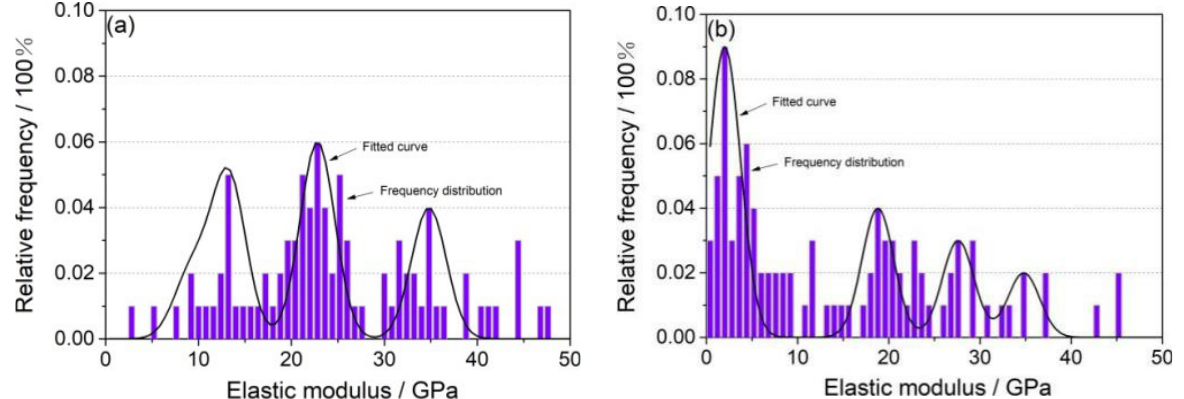
Figure 16. Frequency distribution and Gaussian peak fitting results of samples at 28 days. ( a ) Control. ( b ) O-L-2.